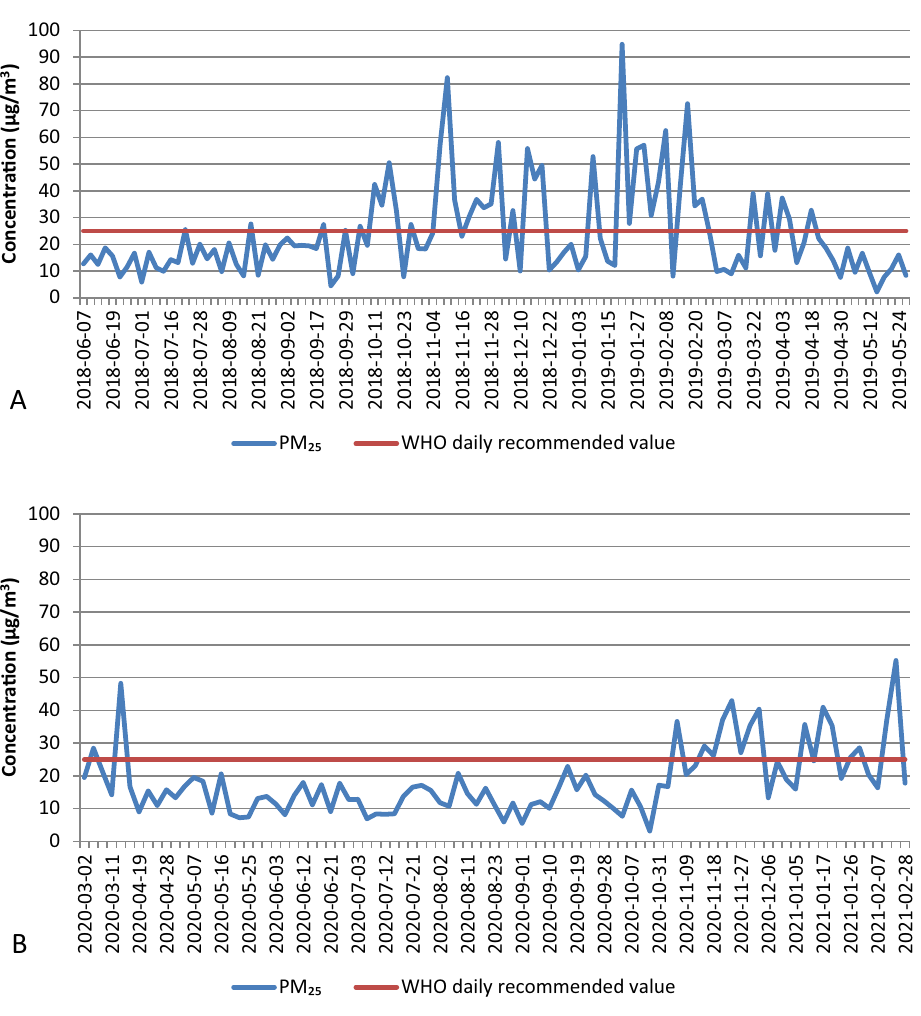
Figure 2. The daily concentration of PM 2.5 fraction at AGH station in Krakow. ( A ) The values for the year 2018/2019 and ( B ) the values for the year 2020/2021. Red line-WHO recommended daily limit